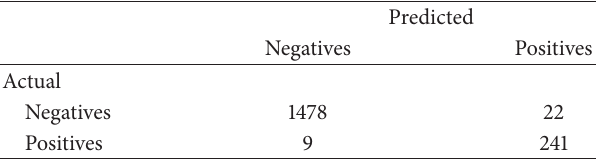
Table 7: The evaluation matrix for nipple tracking.